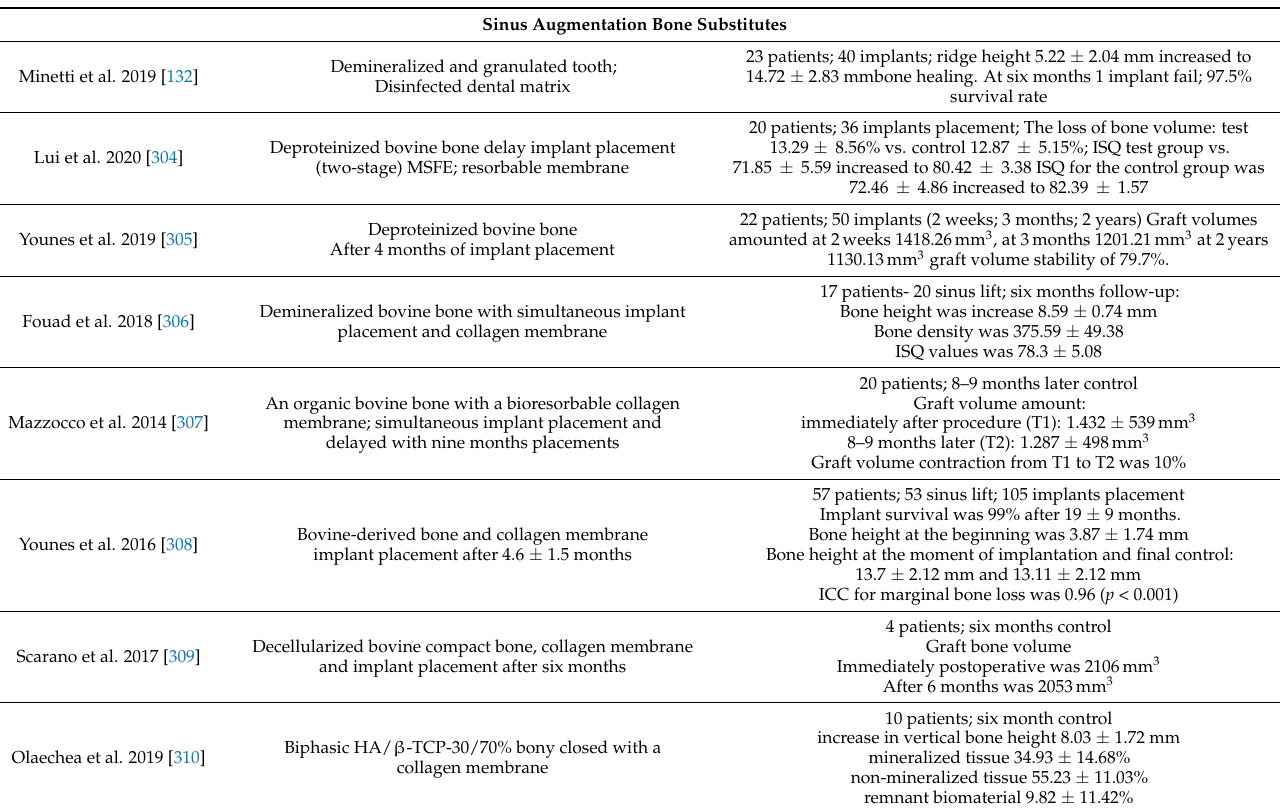
Table 3. Summary of the biomaterials and graft for sinus augmentation procedure. Sinus Augmentation Bone